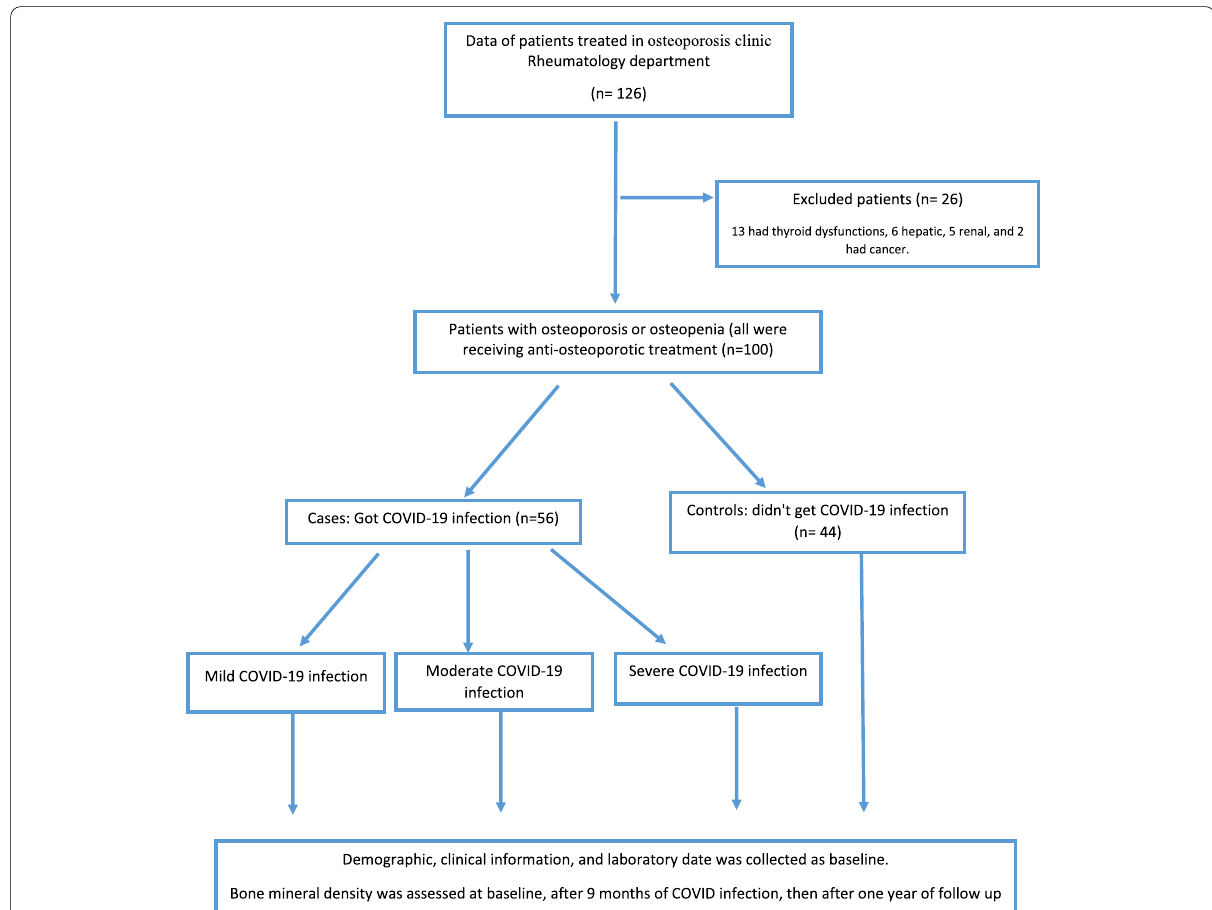
Fig. 1 Consort flow diagram of the case control